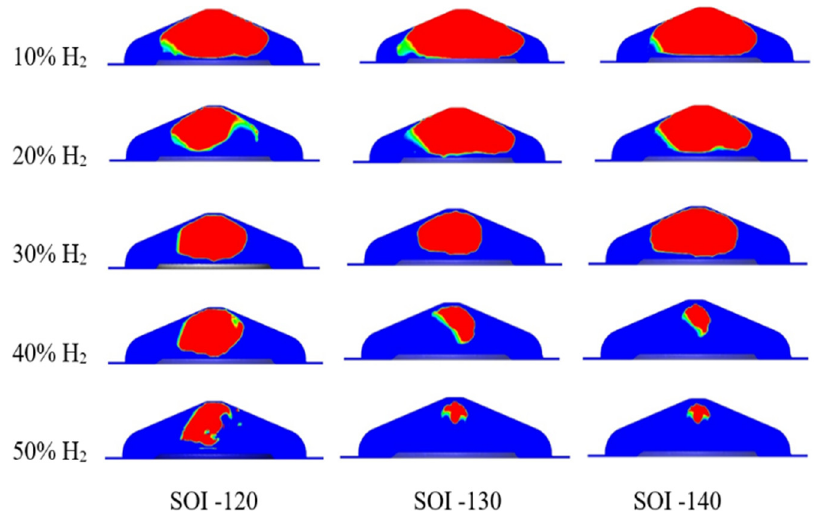
Figure 9. Contours of OH for different case studies at Top Dead Center (TDC).